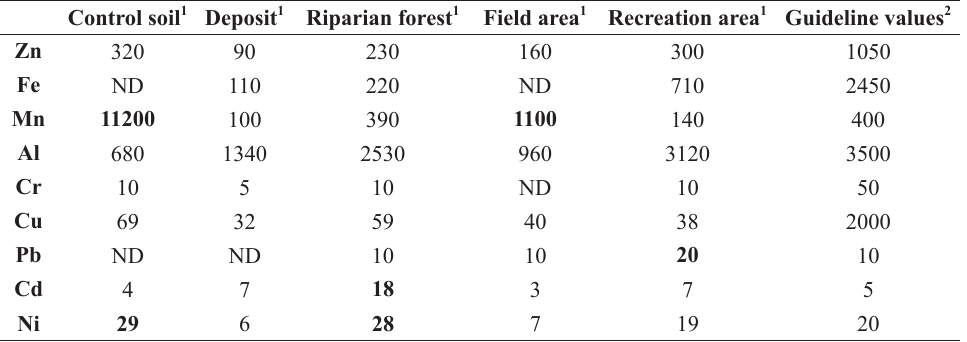
Comparison of chemical data obtained from soil samples with the values of Resolution